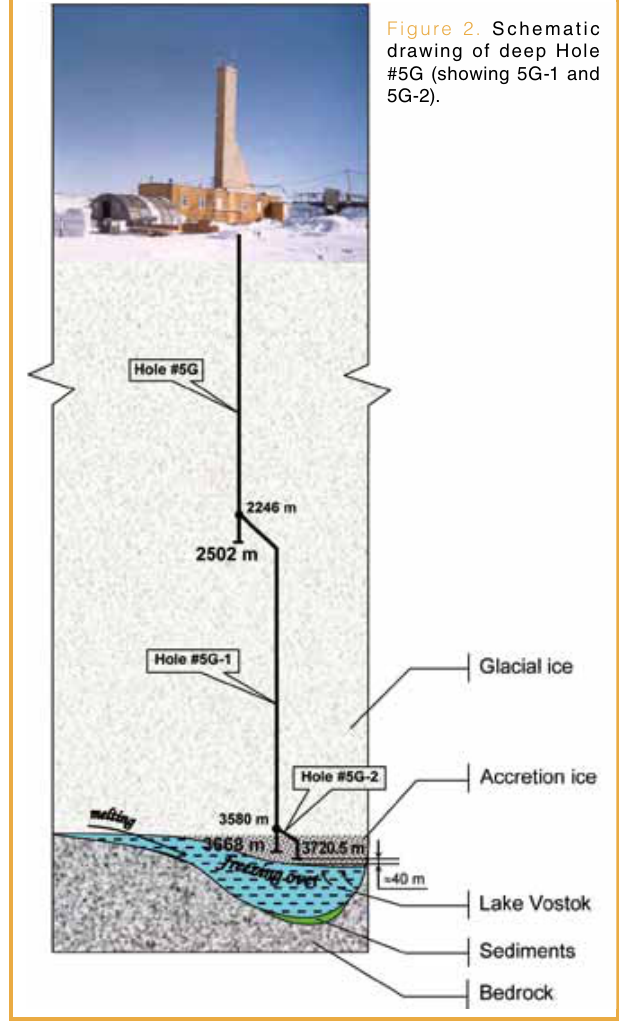
Figure 2. Schematic drawing of deep Hole #5G (showing 5G-1 and